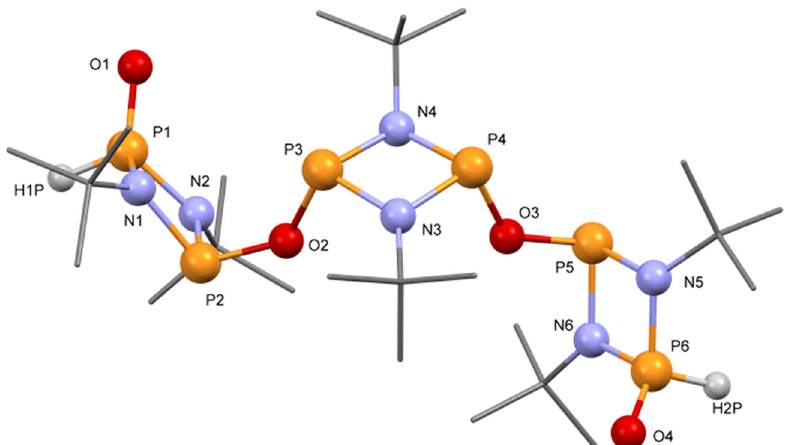
Fig. 4 Hybrid P III /P V trimeric poly-cyclophosphazane (5). Solid-state structure of 5 . The tert-butyl groups are drawn as wireframes in all the graphical representations. H atoms are omitted for clarity. For thermal ellipsoid representation, selected bond lengths, and angles see Supplementary Fig.